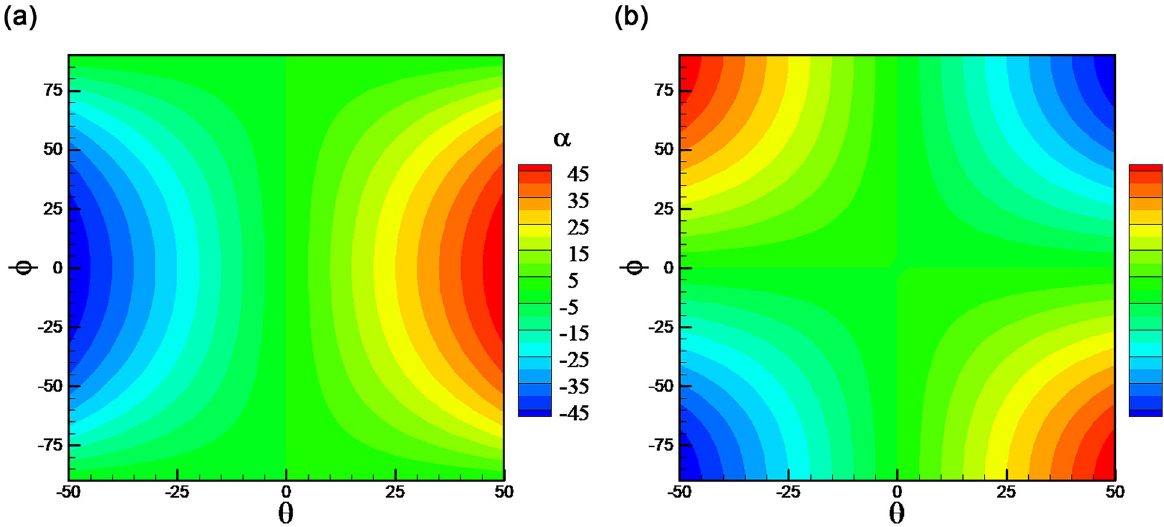
Fig 20. The relationships between θ ~ ϕ and α ~ β . (a) α ~ θ (b) β ~ θ , ϕ .